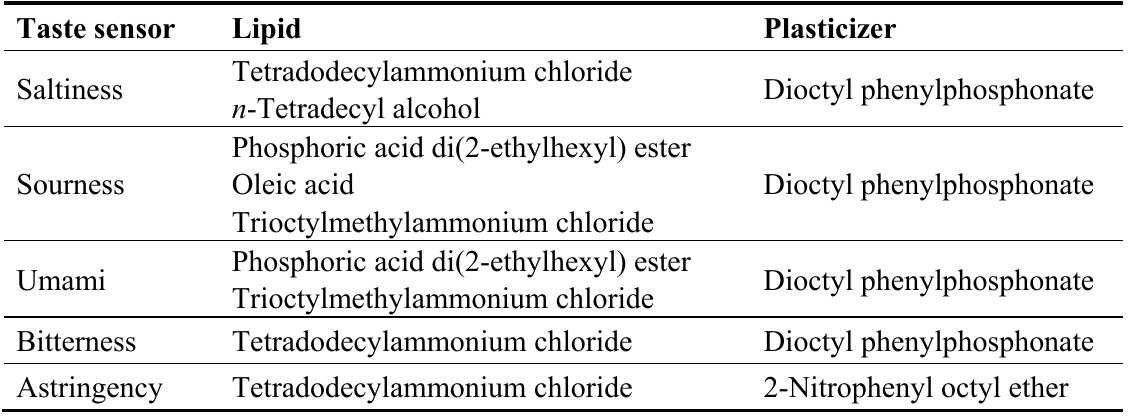
Table 1. Chemical components of the artificial lipid